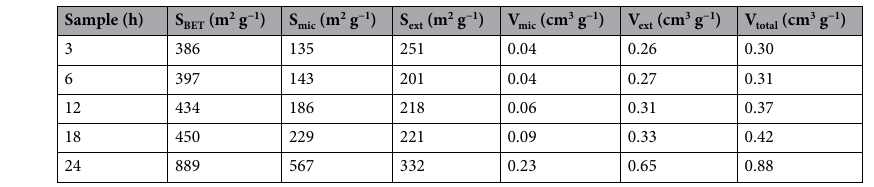
Table 1. Pore structure parameters of HPP at various hypercrosslinking time.